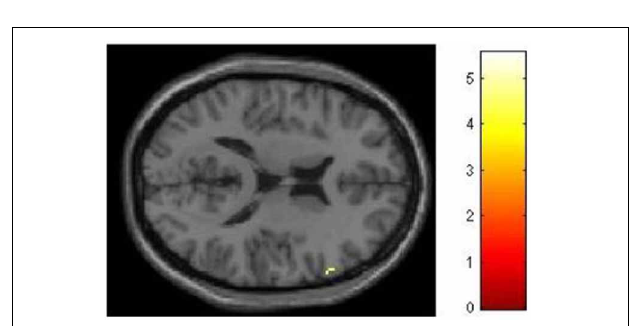
FIGURE 3 | High working memory load activates the right inferior frontal gyrus more when lying successfully than when telling the truth successfully. SPM rendered into standard stereotactic space and superimposed on to transverse MRI in standard space. The bar graph represents the strength of the activation ( T